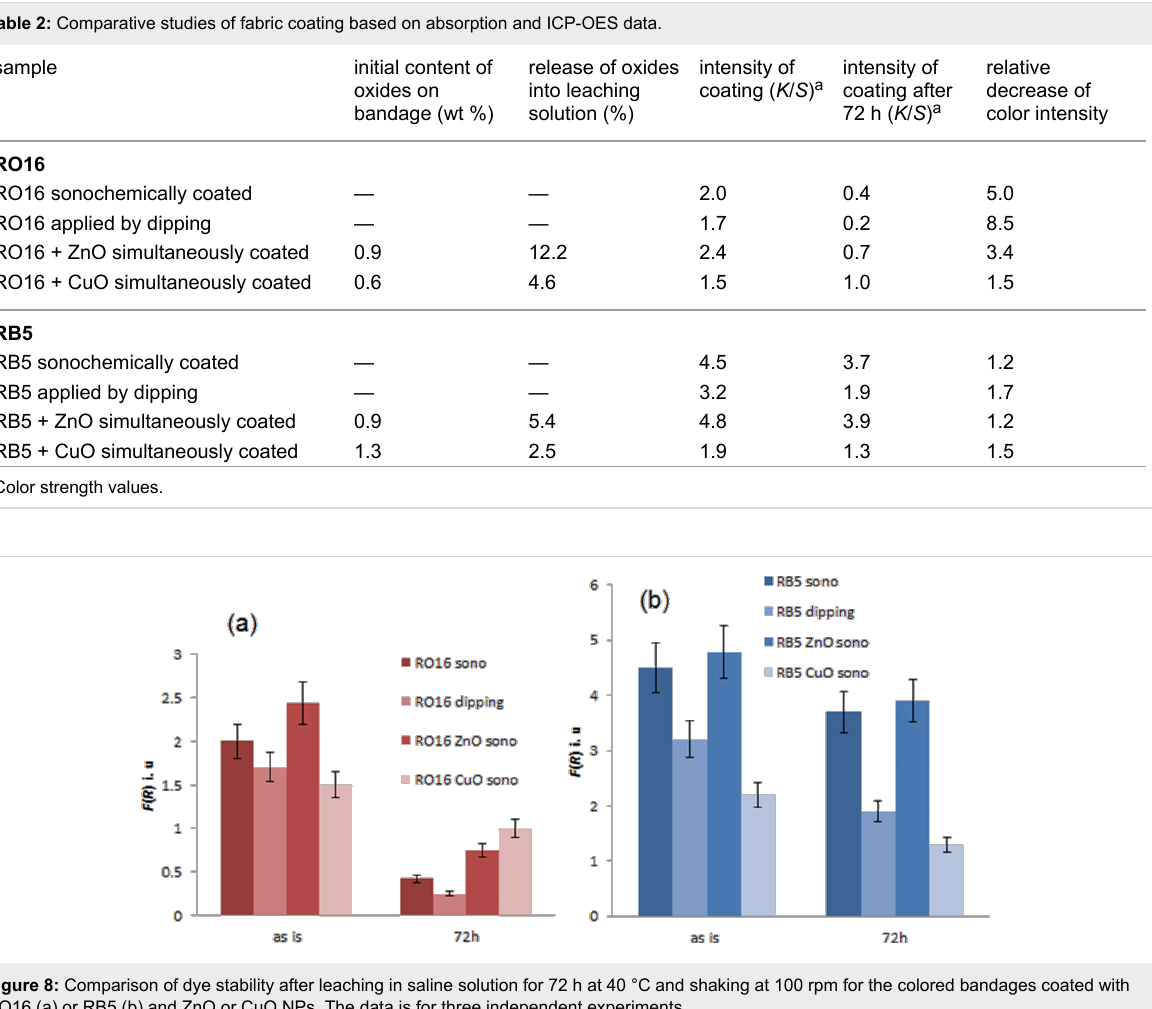
the dye itself is very low and was not influenced by the pres- ence of MO. The color intensity of the sonochemically dyed fabrics was higher than the dip-coated bandages for both dyes based on the K / S values. In addition, the color loss for the dip- dyed samples is more noticeable than for sonochemically coated dye. The sonochenical technique appears to be more efficient for dyeing of textiles compared to the conventional dyeing process. The sonochemical co-deposition of antibacterial nanoparticles and the dye impart two functions in a one-step process that led to stabilization of the dye on the surface while exposed to the